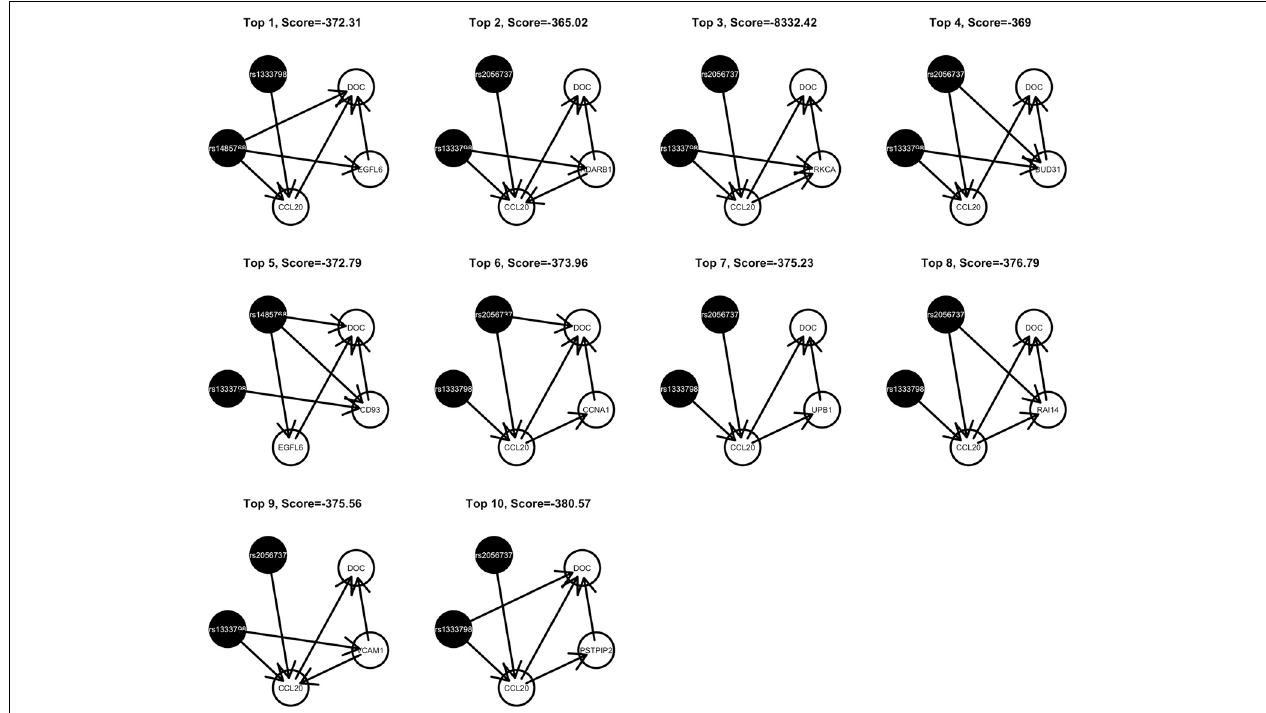
FIGURE 11 | Top scoring five-node network structures for docetaxel reported from nPARS